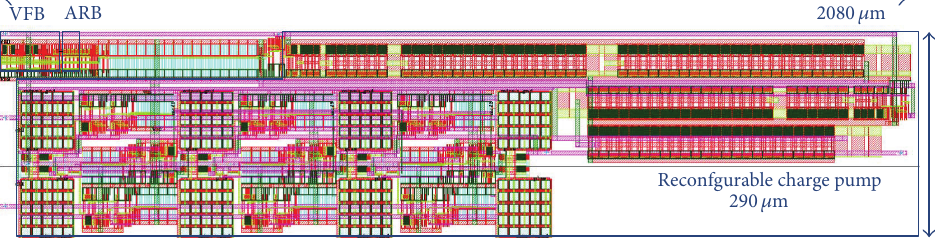
Figure 8: Layout of RCP circuit with the added VPF